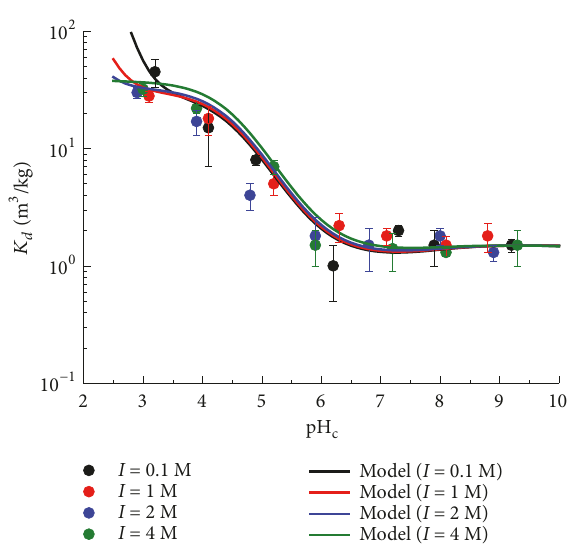
Figure 1: pH c and I dependence of 𝐾 𝑑 in Na-Ca-ClO 4 solutions. Plots are the experimentally measured 𝐾 𝑑 values. The solid lines are the 2SPNE SC/CE model calculation results. The error bars represent the standard deviation of triplicate measurements.